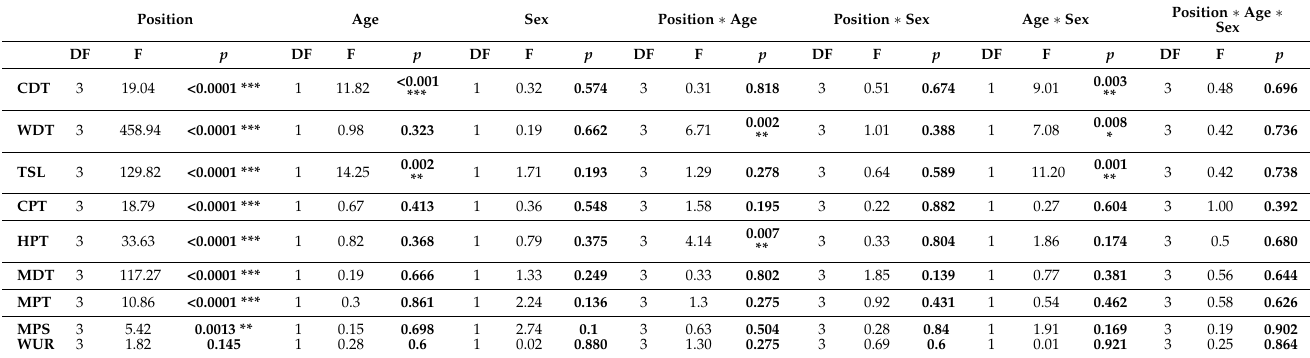
Table 3. Analysis of variance of orofacial reference data. (CDT = Cold Detection Threshold, WDT = Warm Detection Threshold, TSL = Thermal Sensory Limen, CPT = Cold Pain Threshold, HPT = Heat Pain Threshold, MDT = Mechanical Detection Threshold, MPT = Mechanical Pain Threshold, MPS = Mechanical Pain Sensitivity, WUR = Wind Up Ration). * p < 0.05; ** p < 0.001; *** p <